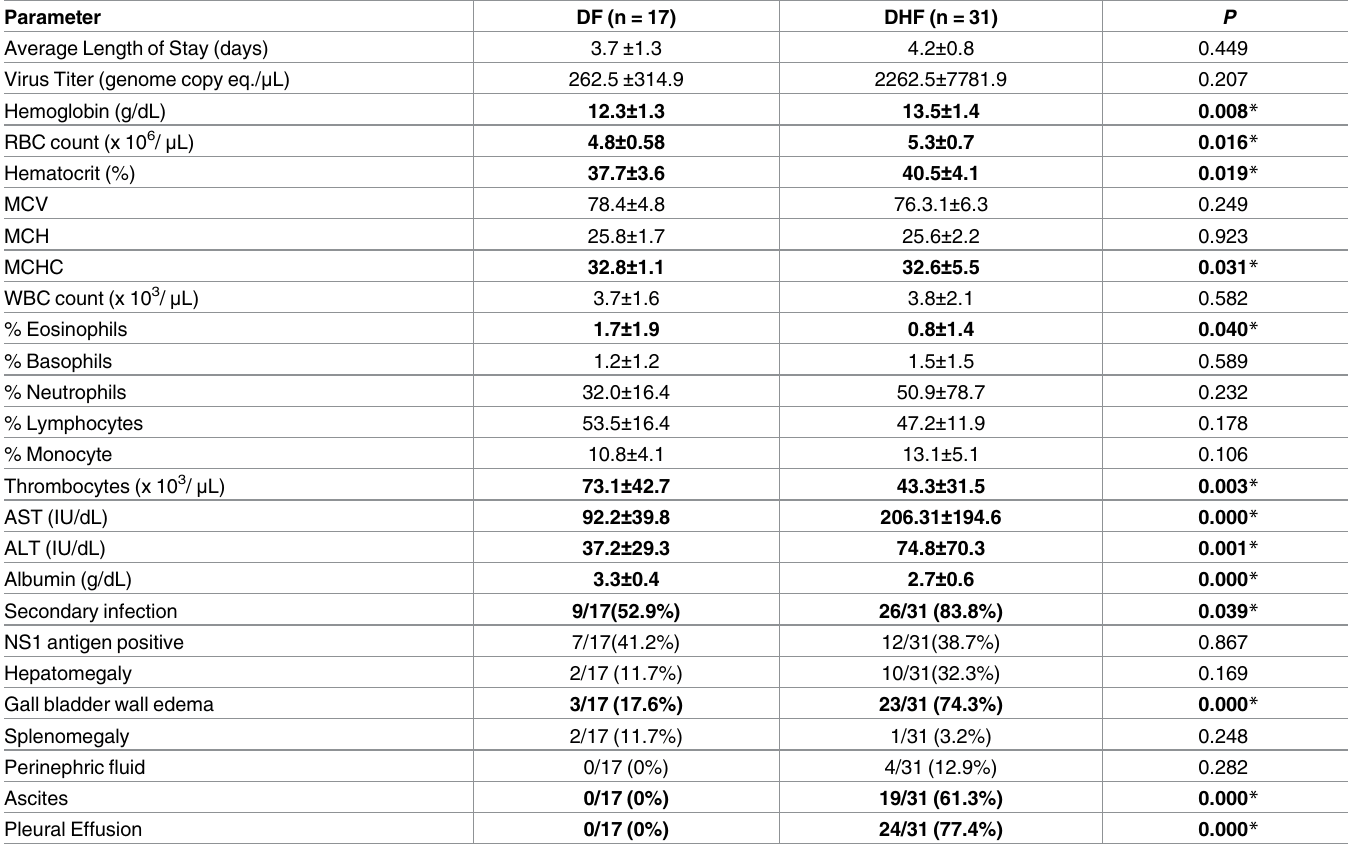
Table 2. Characteristics of dengue-confirmed children (n =